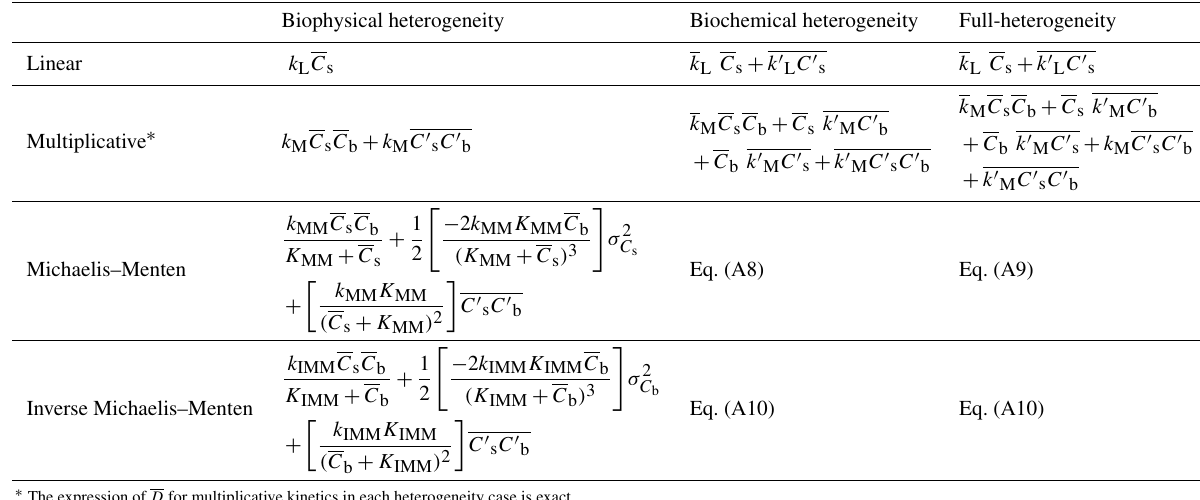
Table 2. Summary of macroscale equations for the decomposition rate ( D